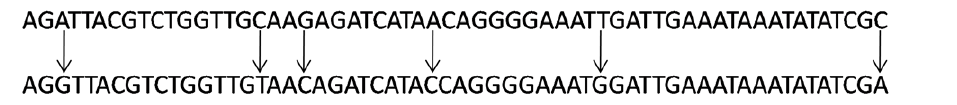
Figure 2. Creation of mutated sequences. Example of the 10% of mutation (6 bases) of a 60 bases sequence, creating a new sequence (bottom) from the original sequence (upper). The loci and the replacing bases are randomly chosen.